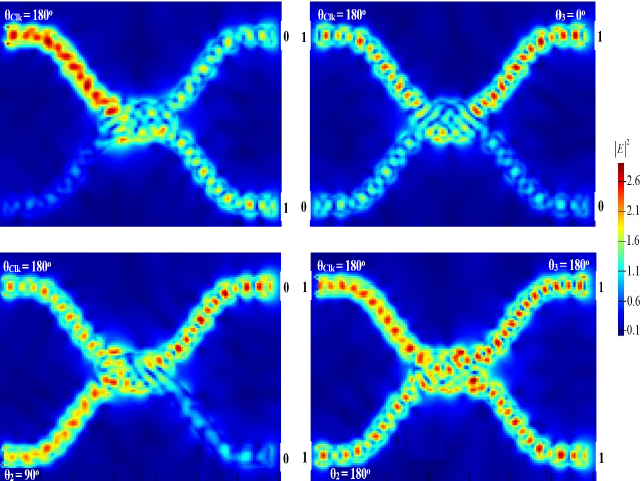
Figure 14. Light field distributions for XNOR function utilizing 2 × 2 silicon waveguide at 1.55 μ m.